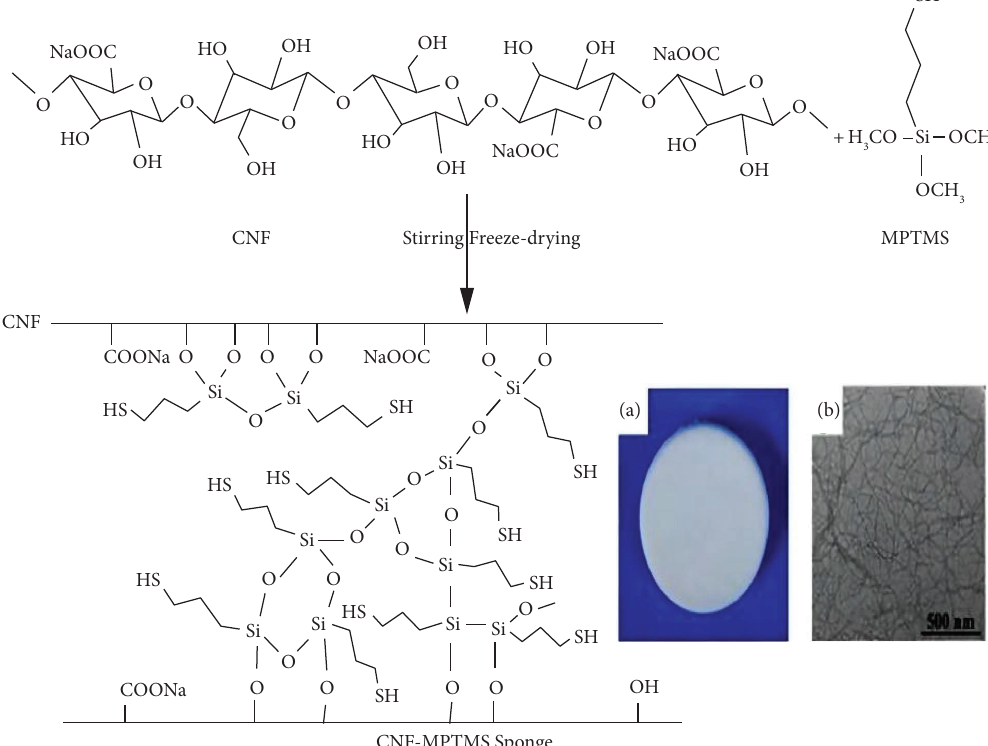
Figure 12: Reaction mechanism for the carboxylate-containing CNFs with MPTMS sponge forming Si-O-Si chain and resulting in a thiol- functionalized cellulose sponge to use as Hg 2+ heavy metal adsorbent: (a) photograph of the thiol-functionalized cellulose sponge morphology which consists of anisotropic porous; (b) TEM image of CNFs in the scale of 500nm [37]. Copyright and permission from Springer